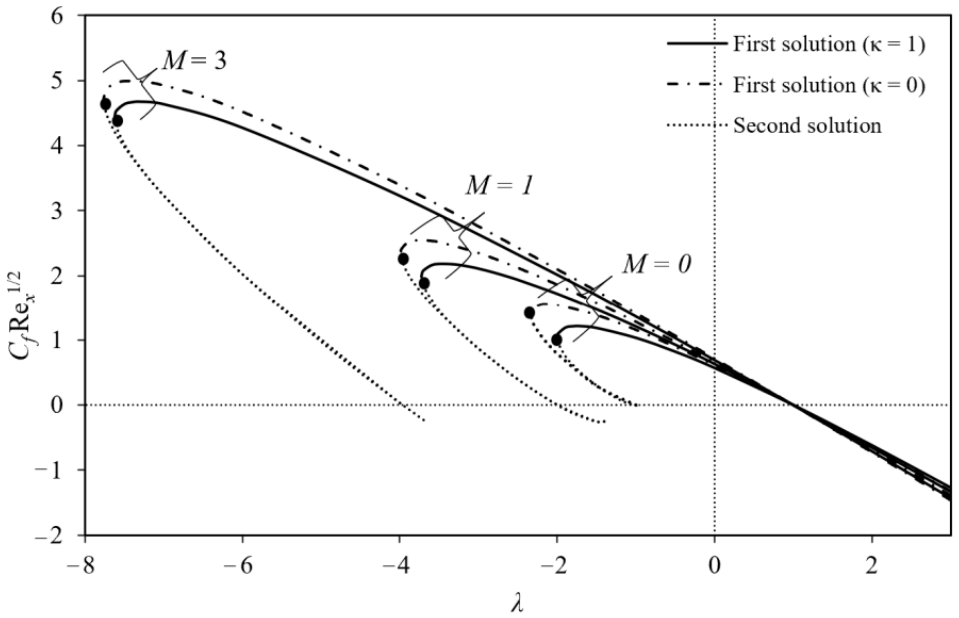
Figure 2. The variations of C f Re 1/2 x with the stretching/shrinking parameter, λ , for different M and κ when φ = 0.01, A = 1, and δ = 1.